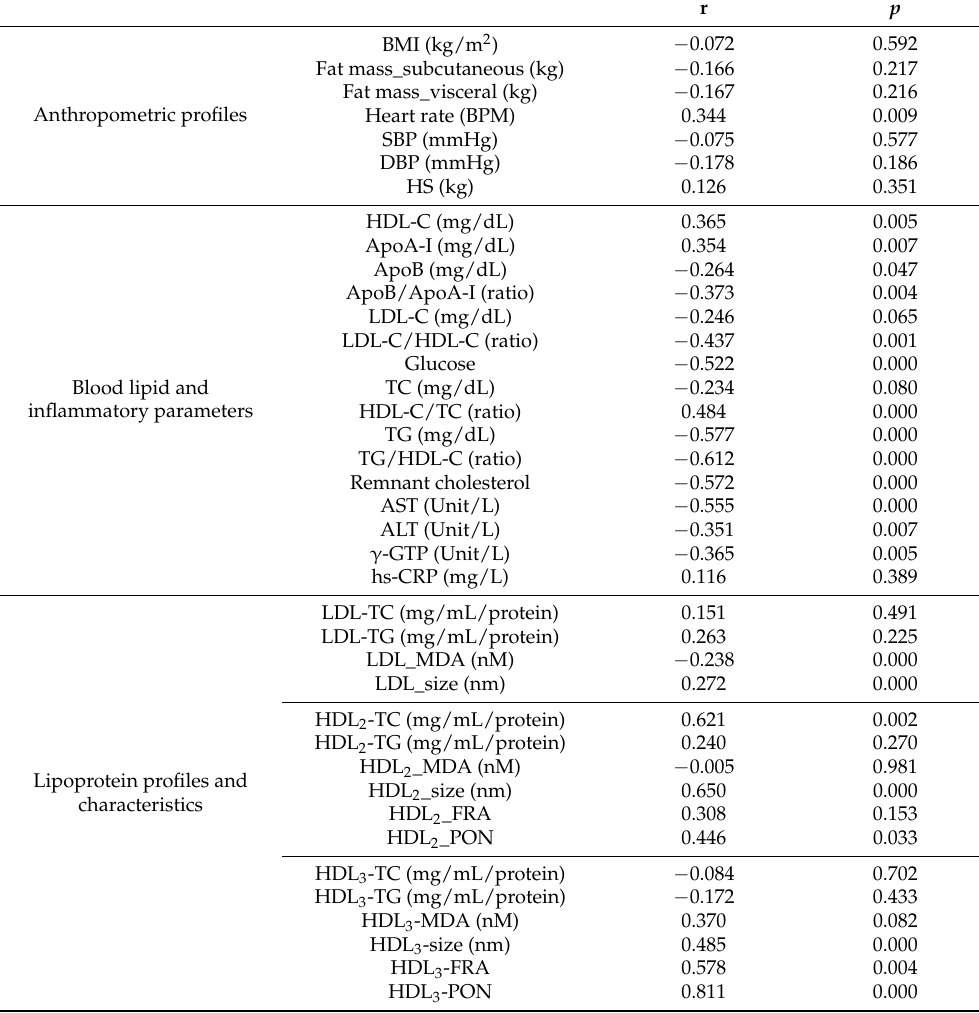
Table 4. Spearman correlation (r) and p values of linear regression for all participants (n =